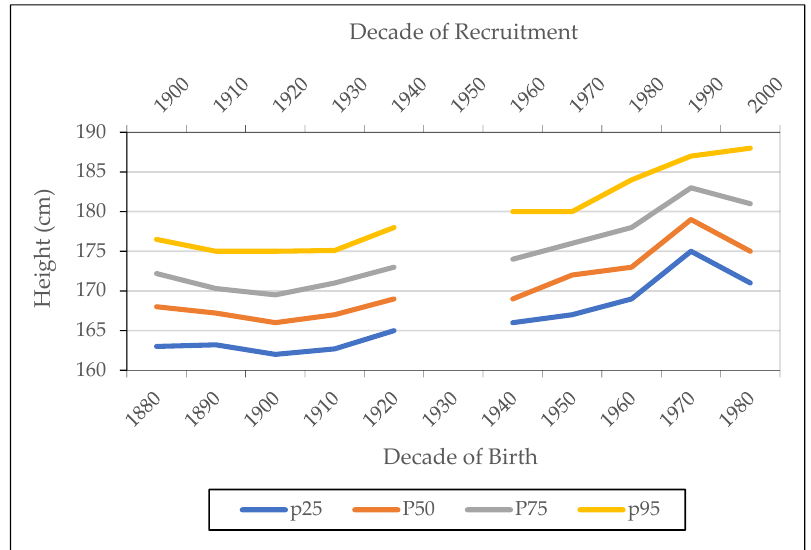
Figure 10. Height percentiles by decade of birth/recruitment. Source: AMSB, ACDS. Own work.